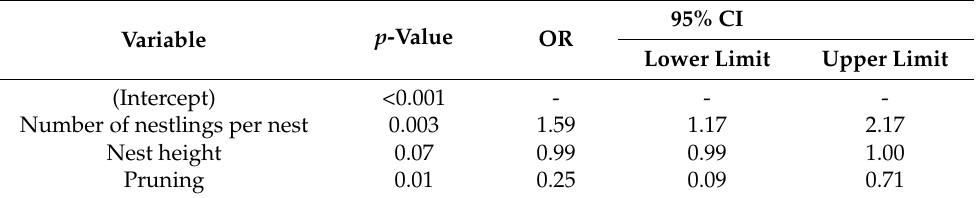
Table 3. Results from the multivariate logistic regression analysis. Category, p -value, odds ratio (OR), and 95% confidence interval (CI) lower and upper limit are reported for the variables that were retained in the model showing an association or relevance on the positivity to Giardia spp. on Monk Parakeet samples.